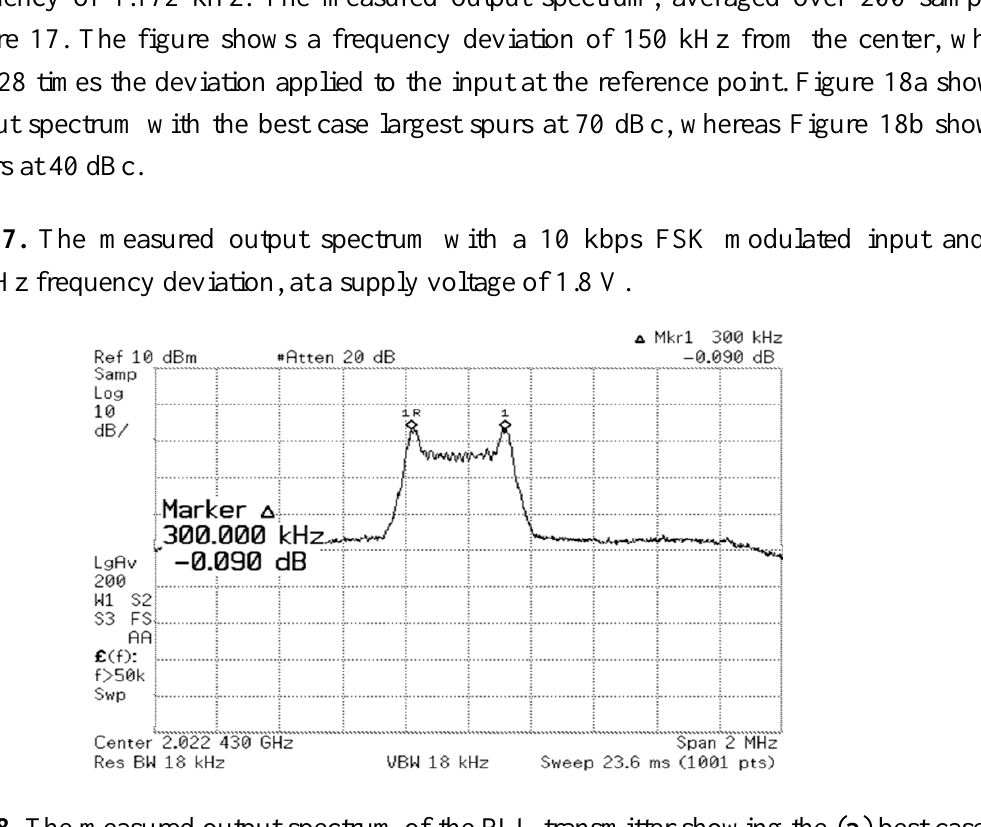
Figure 18. The measured output spectrum of the PLL transmitter showing the ( a ) best case spurs. ( b ) worst case